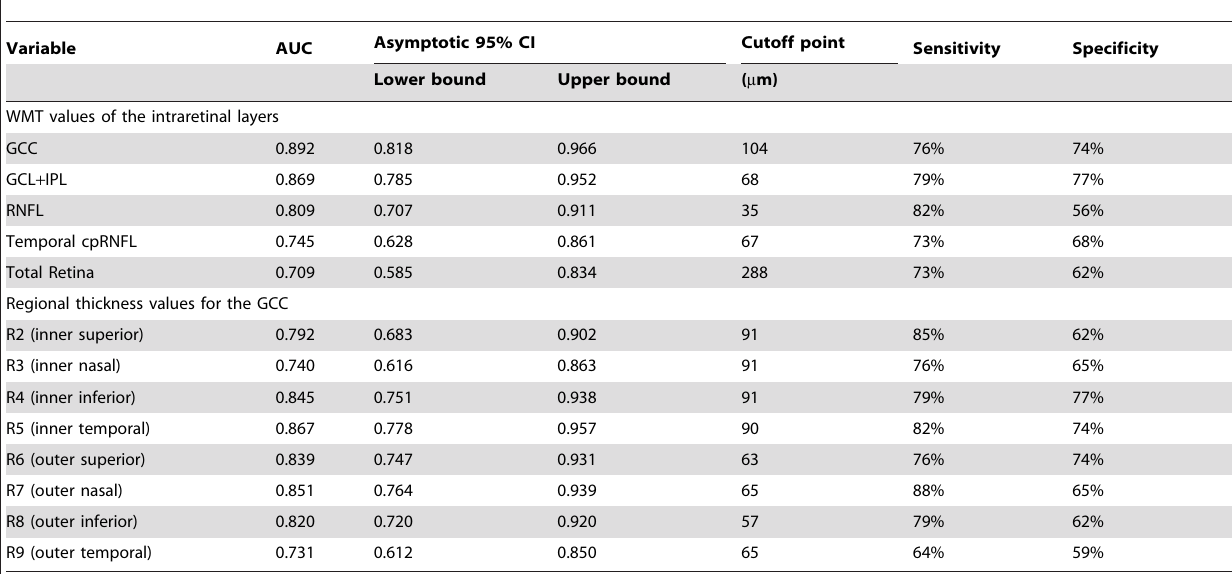
Table 4. Results of the ROC analysis for the WMT thickness variables which showed significant difference between the eyes not affected with ON and controls and for the regional GCC thickness